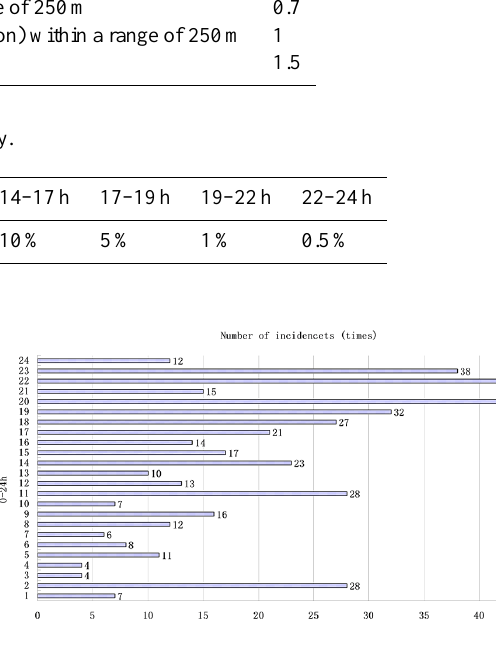
Table 2. Estimating the open-field area location factor ( C d ) based on surrounding terrain (quoted from IEC62305, 2006). The bare space exposure and its sounding C d Terrain that is 8m higher within a range of 250m